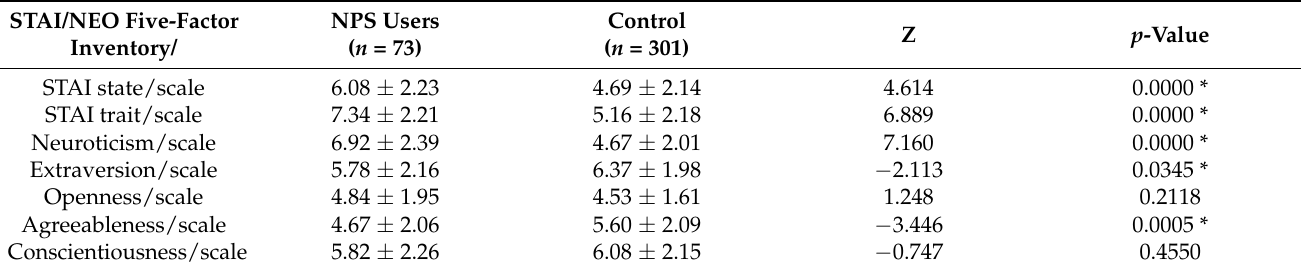
Compared to the control group, no statistically significant difference in the frequency of the genotype variants for the DAT1 gene was found in the subjects using NPS (9/9 and no statistically significant difference in the frequency for the DAT1 alleles was found between the NPS users and the control group (9 0.19 vs. 9 0.25, 10 0.81 vs. 10 0.75, χ 2 = 2.37, p = 0.124). Compared to the controls, the study group subjects were observed to have significantly higher scores (Table 3) on the STAI state scale (M 6.08 vs. M 4.69, p < 0.001), the STAI trait scale (M 7.34 vs. M 5.16, p < 0.001), and the NEO Five-Factor Inventory neuroticism scale (M 6.92 vs. M 4.67, p < 0.001). Table 3. STAI and NEO Five-Factor Inventory results (sten scale), shown as mean ± standard deviation for the healthy controls and the NPS users; significance of the difference was assessed by the Mann–Whitney U test.